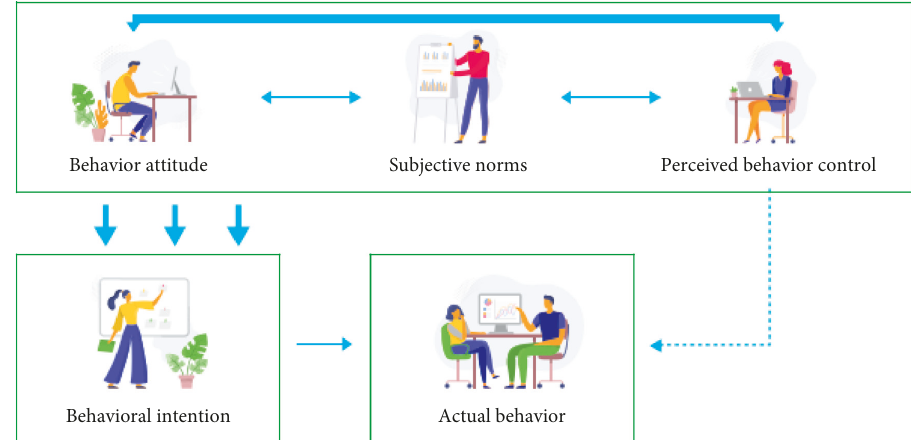
Figure 3: Theoretical model of planned behavior.